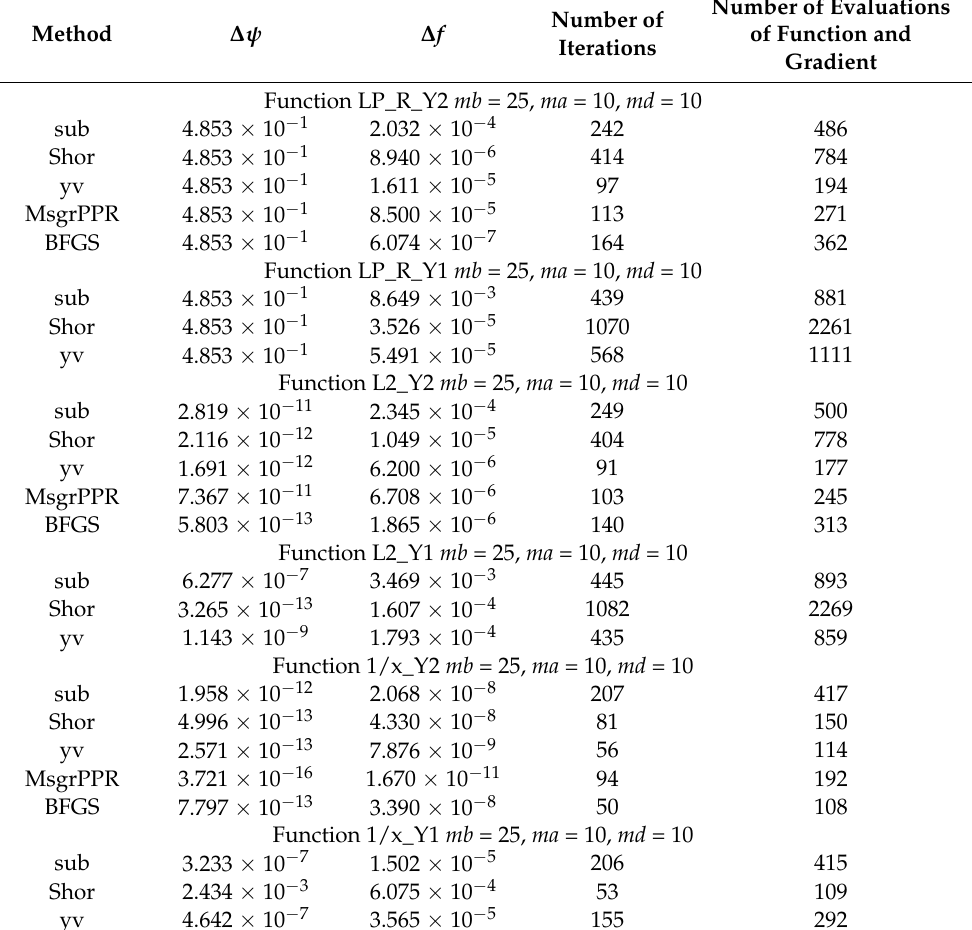
Table 3. Results of calculations for dimensions n = 1000, m = 100 with mb = 25.